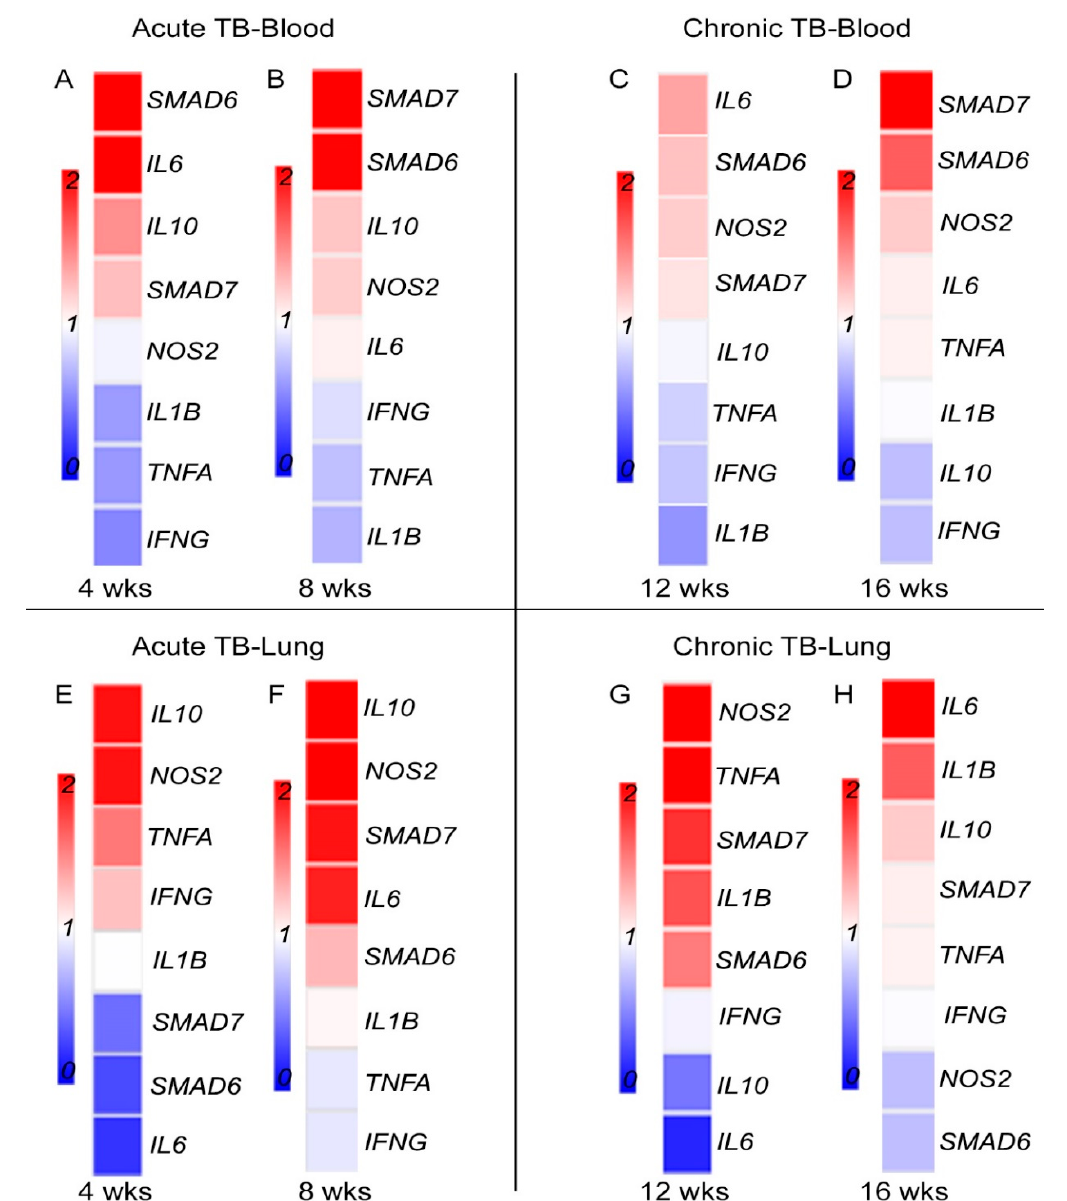
Figure 6. E ff ect of Fe-supplementation on the expression of host immune response genes in Mtb-infected rabbits. Heat map of selected immune response gene expression in the blood ( A – D ) or lung ( E – H ) during acute (4 and 8 weeks; A , B , E , F ) or chronic (12 and 16 weeks; C , D , G , H ) stages of infection in rabbits treated with Fe. The data from Fe-supplemented animals was calibrated with the corresponding levels in placebo-treated animals. Host house-keeping gene ( GAPDH) expression was used to normalize target gene expression. Red color indicates up-regulation and blue color indicates down-regulation. The gradient in color indicates the trend towards up- or down-regulation.